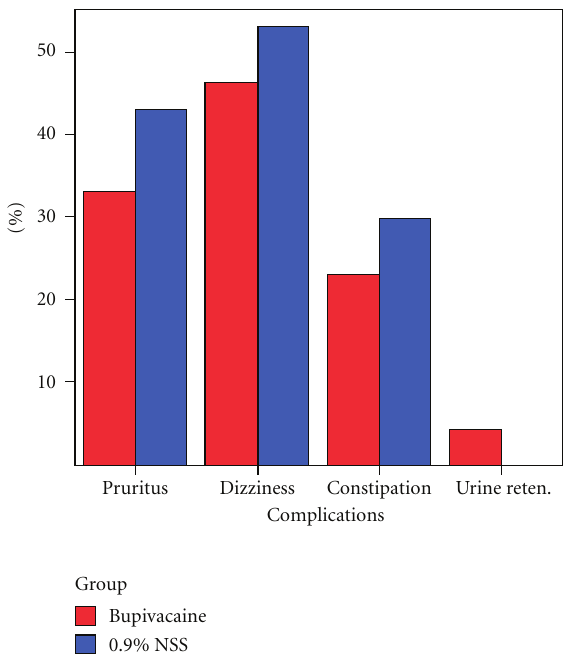
Figure 4: Morphine-related postoperative